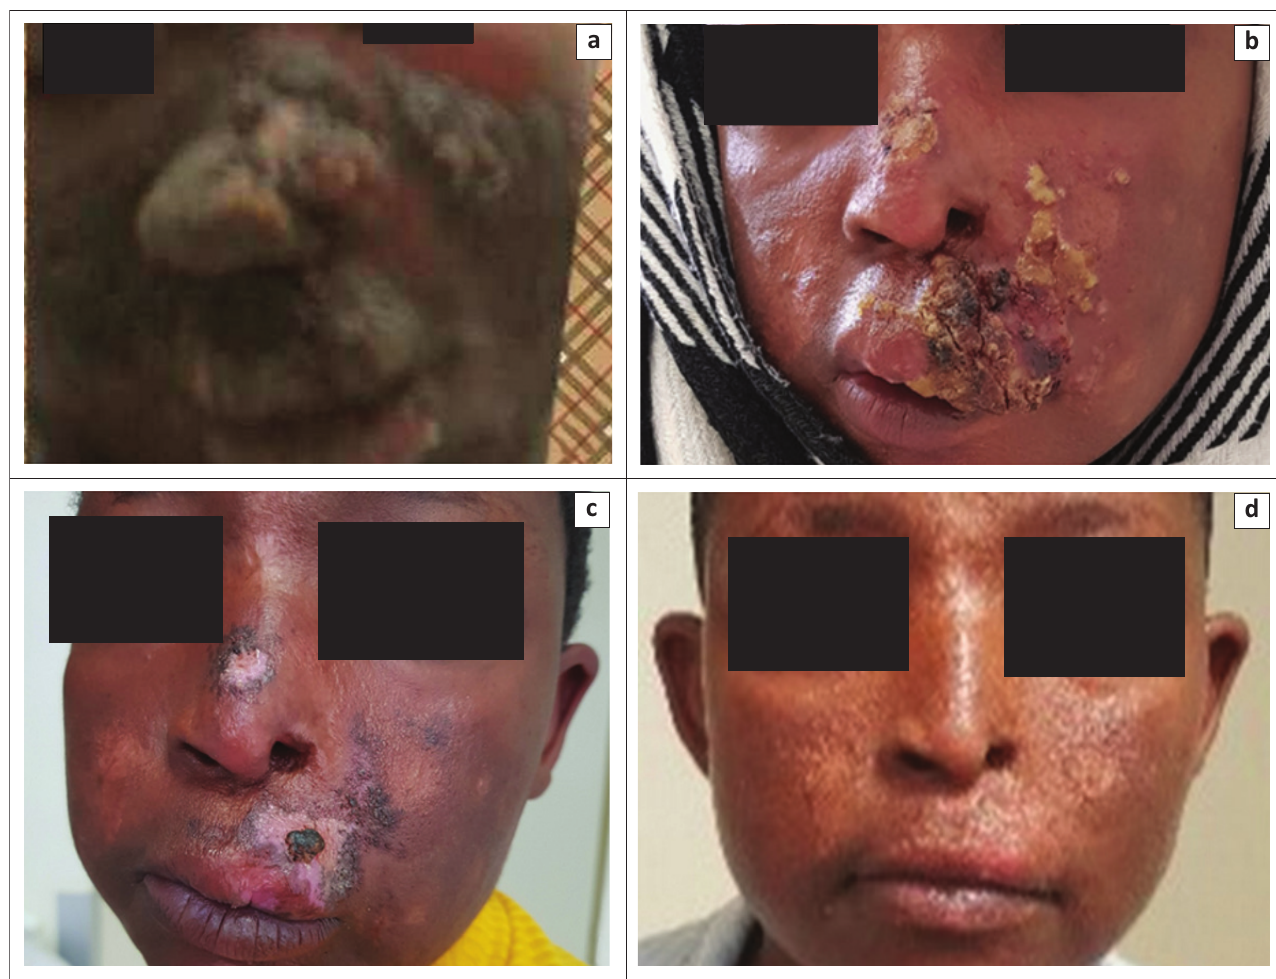
FIGURE 1: Clinical images of presumed case of emergomycosis, with (a) large crusted facial lesions at initial presentation; (b) a marked improvement following 3 months of oral treatment; (c) minimal residual disease some 7 months later; and (d) complete disappearance of the cutaneous lesions at one year, with mild residual scarring